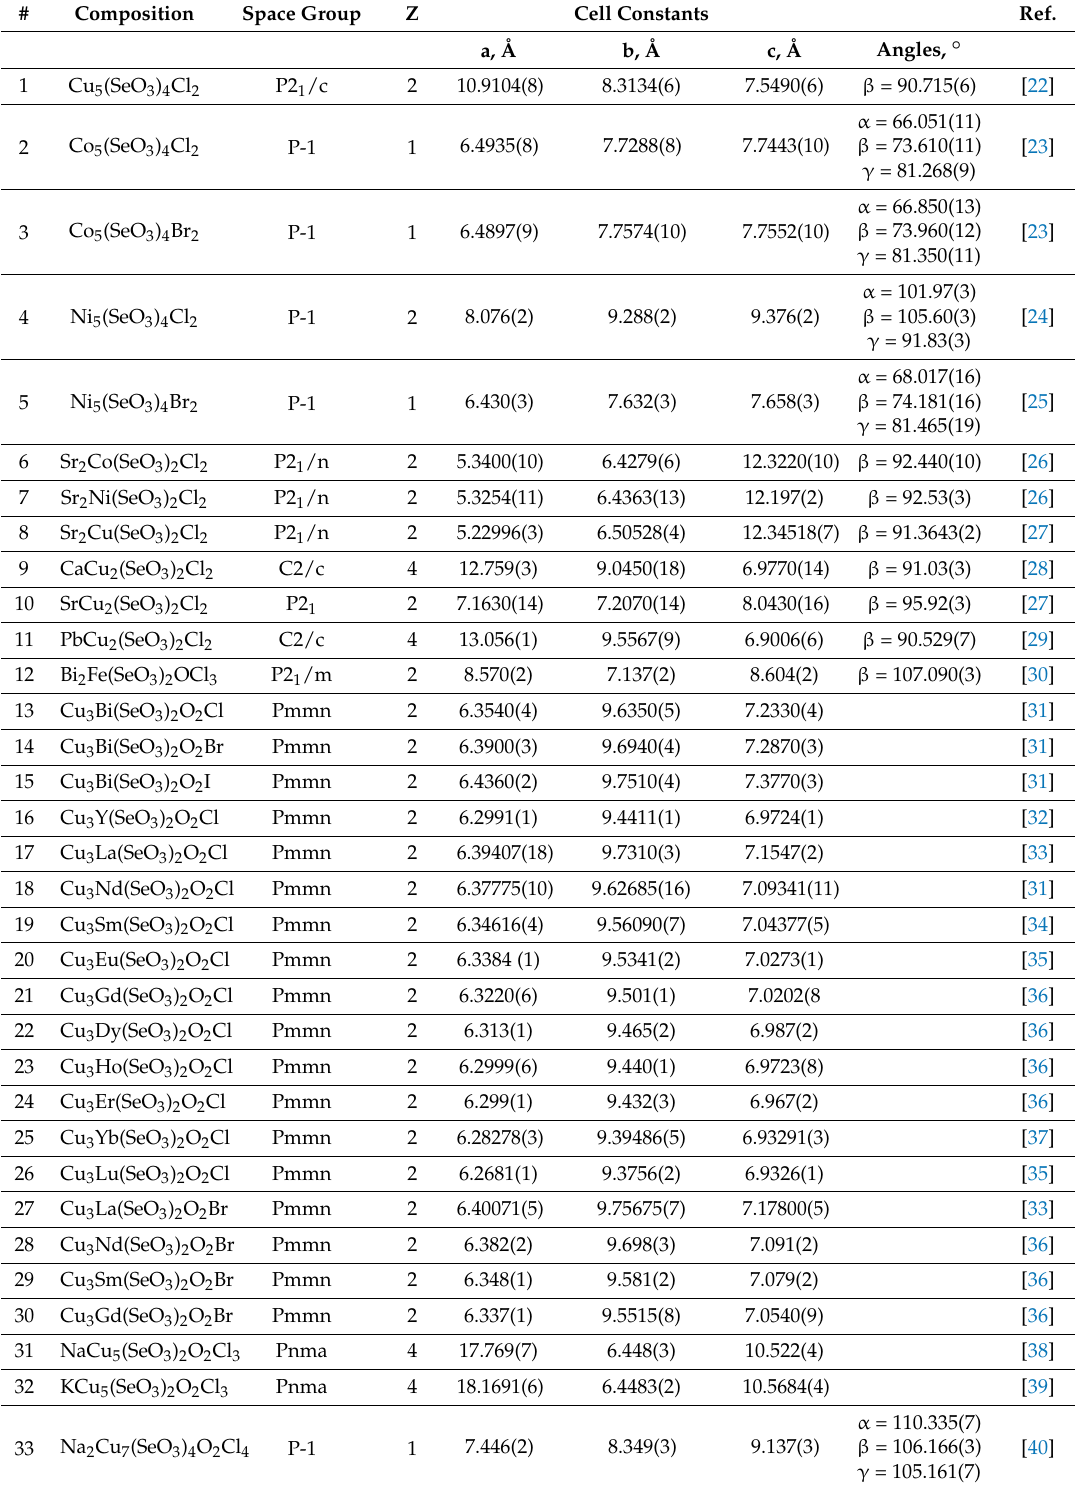
Table 1. Compositions and crystallographic data for transition metals selenite halides with described magnetic